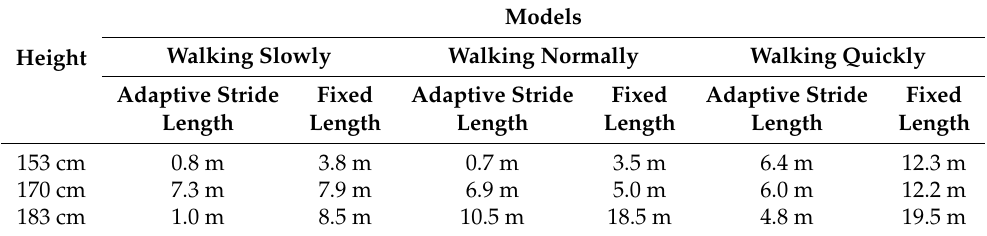
Table 2. Positioning errors with different height and under different walking